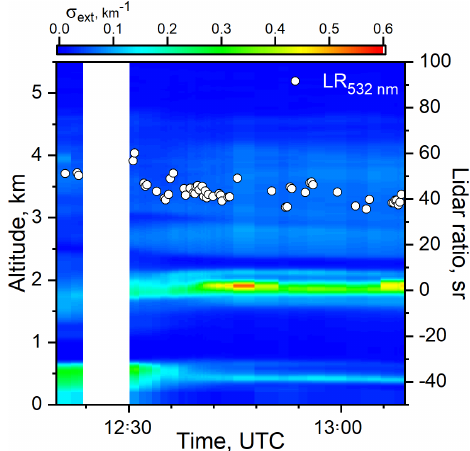
Figure 9. Spatio-temporal variability of extinction coefficient (colour map) and extinction-to-backscatter ratio (white dots) at 532nm from on-road mobile measurements along the Lille– Dunkerque transect on 26 August 2016